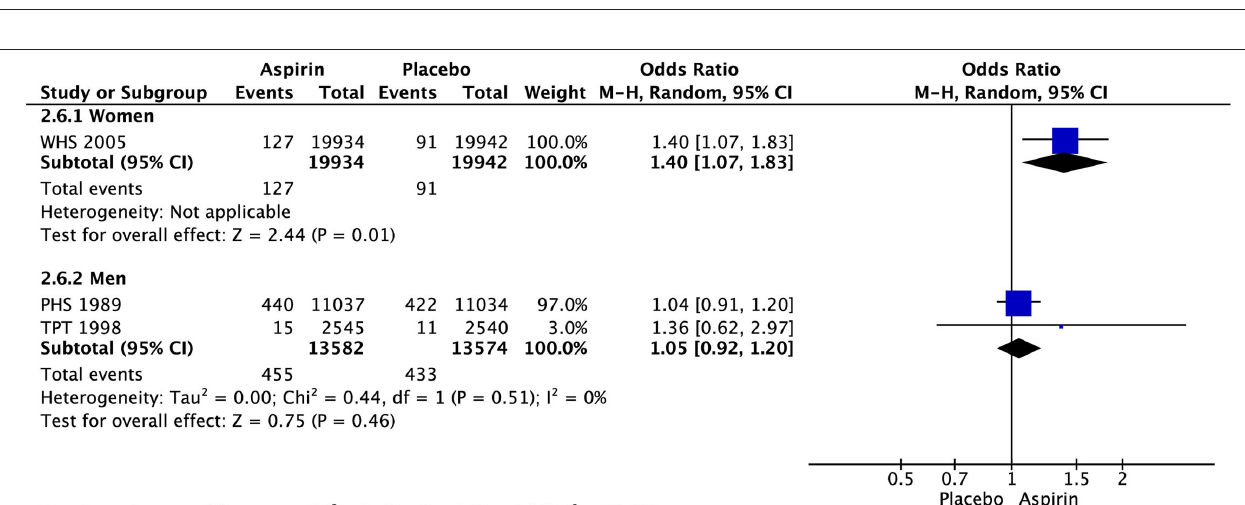
FIGURE 6 | Major bleeding in women and men taking aspirin or placebo.